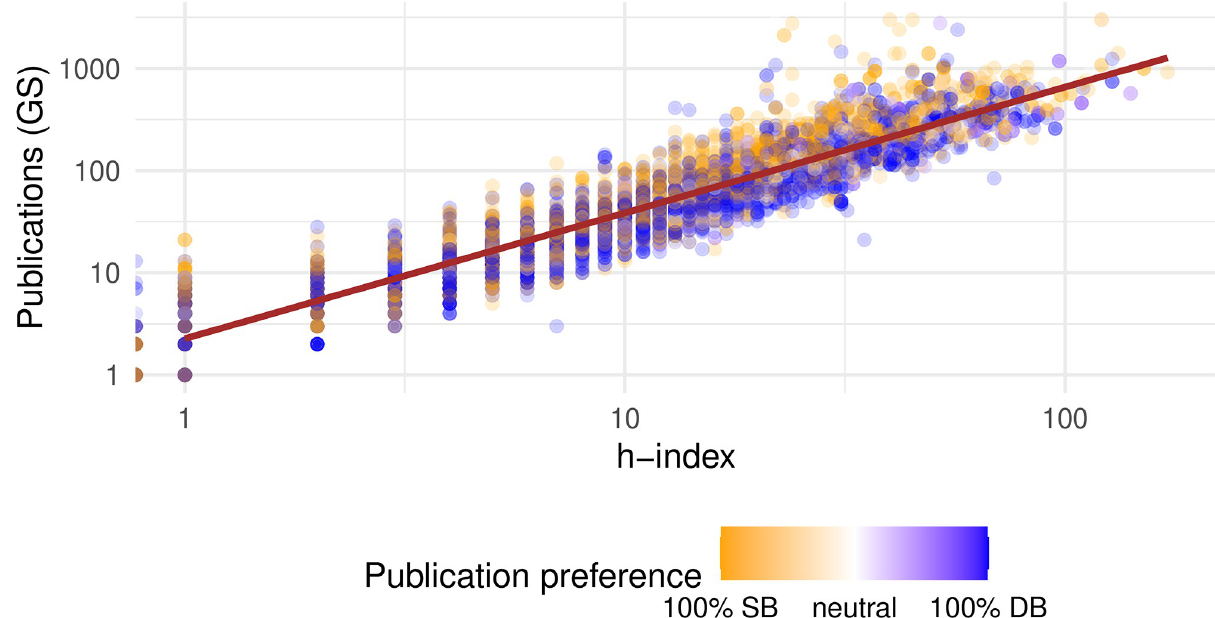
Fig 14. Scatterplot of the relationship between number of publications (GS) and and h-index for all authors with data (log scale). Color denotes the ratio of an author’s papers from single-blind conferences in this dataset. Brown line denotes linear regression of all data points.